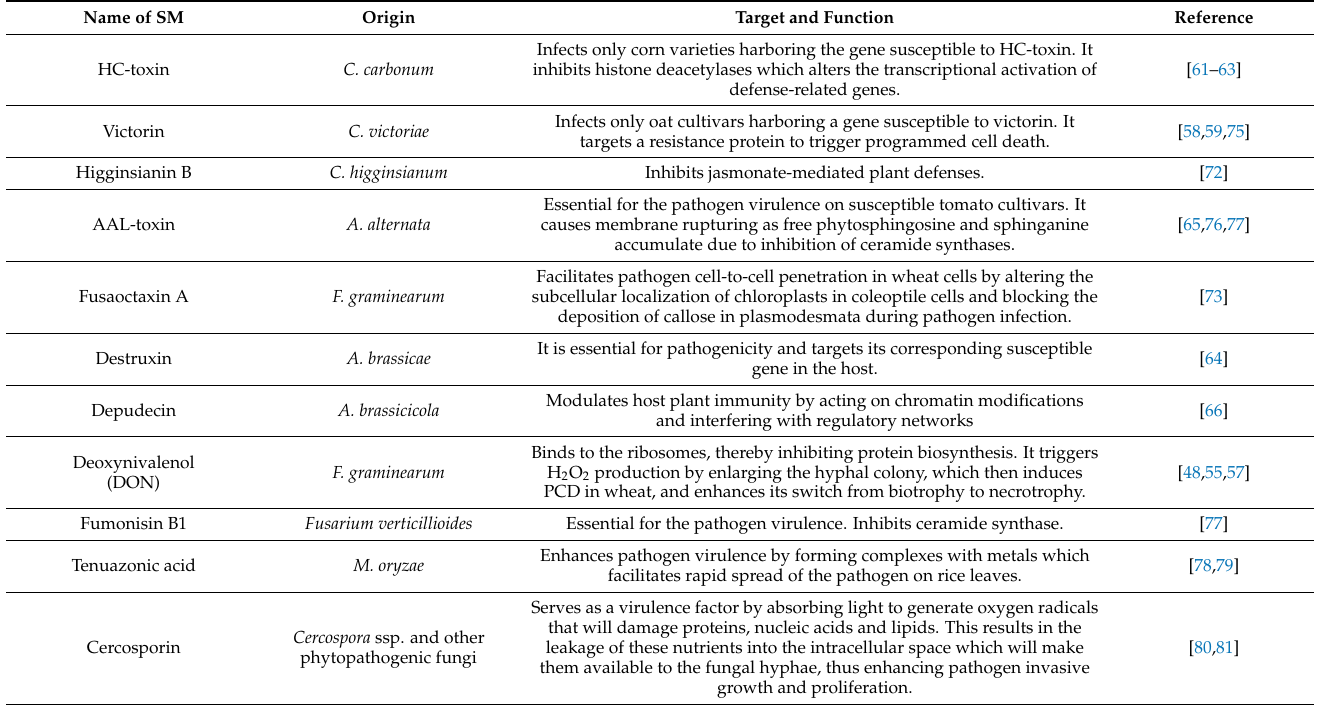
Table 1. Fungal SM effectors involved in manipulation of host